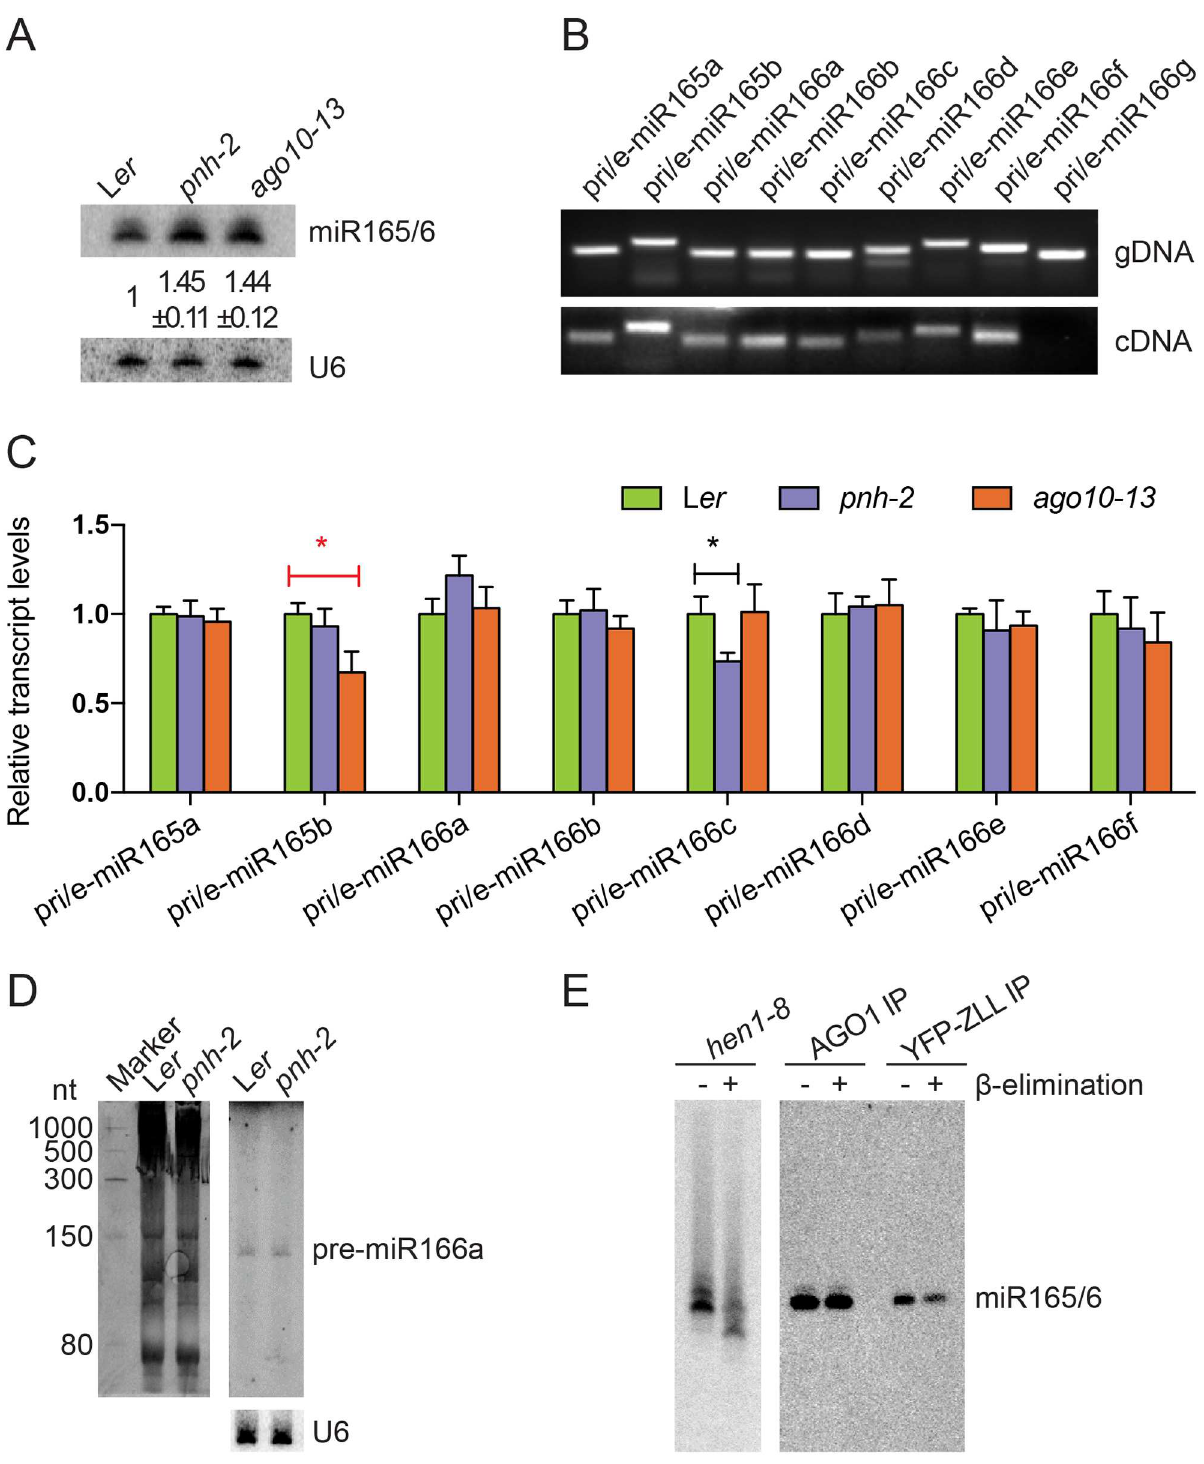
Fig 3. ago10 mutations do not affect miR165/6biogenesis. (A) Mature miR165/6levels were increasedin the seedlingsof pnh-2 and ago10-13 as comparedto wild type (L er ) in six biologicalreplicates. The numbers represent mean ± standarddeviations. (B) PCR to test the specificity of primers from each MIR165/6 locus, using genomicDNA as the template (upper panel); RT-PCR to determine whetherthe nine MIR165/6 genes were expressed(lower panel). Reverse transcription was conductedwith random primers followedby PCR with the same pairs of gene-specificprimers as used for the PCR with genomicDNA above. The primers were designedsuch that the sum of pri- and pre-